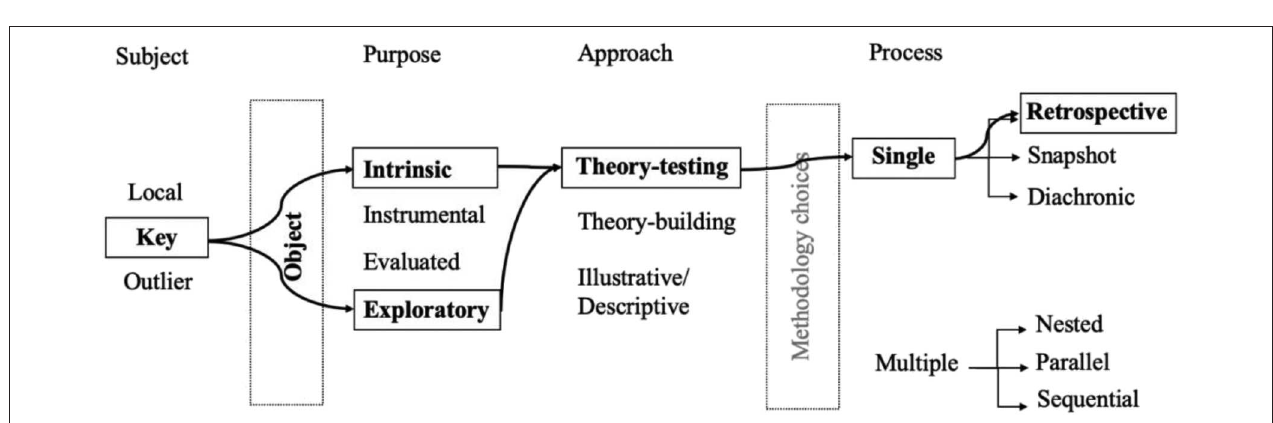
FIGURE 2 | The transformation of agency costs in the adoption of blockchain technology. The size of a node indicates the importance of a role that plays in the network. The role of a third-party Z becomes more crucial and thus the size increases, and so does the importance of reputation mechanism. The thickness of arrows indicates the load of activity. The distance between the agent Y and the principal Y’ implies the consistency of interests from both parties. Adopting blockchain reduces distances between nodes and improves consistency—the shorter the distance, the smaller the residual losses.